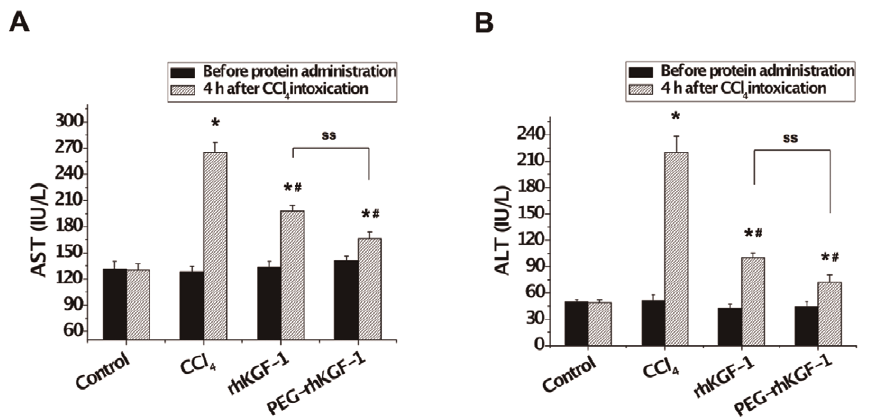
Figure 7. Effect of solid-phase PEGylated rhKGF-1 on serum AST and ALT levels in rats intoxicated with CCl 4 . 48 male SD rats were randomly divided into four groups (12 rats/group): enalpril interventional group A (rhKGF-1-pretreated groups), enalpril interventional group B (PEGylated rhKGF-1-pretreated groups), injury-model group and healthy control group. The test groups were pretreated with non-PEGylated and PEGylated rhKGF-1 24 hours prior to 2.5 mL/kg CCl 4 administration. Four hours after the intraperitoneal injection of CCl 4 , rats were killed and their serum AST/ALT levels were determined. *, p , 0.05 vs control group; # , p , 0.05 vs injury-model group; ss , p , 0.05 between indicated groups.